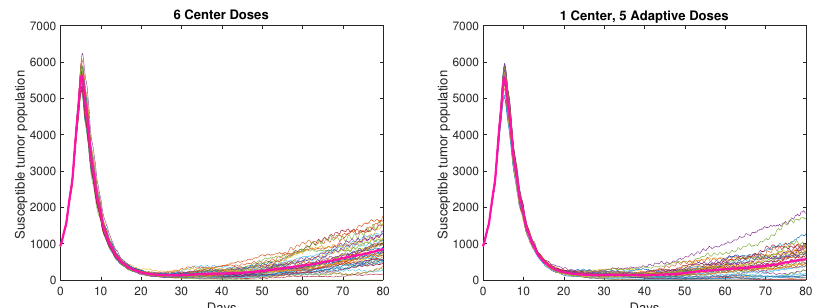
Figure A2. All simulations for a AT = 0.08, with the thicker pink curves denoting the mean of the trajectories. The left figure shows the simulations with 6 center viral doses administered, and the right figure shows the simulations with 1 center and 5 adaptive doses